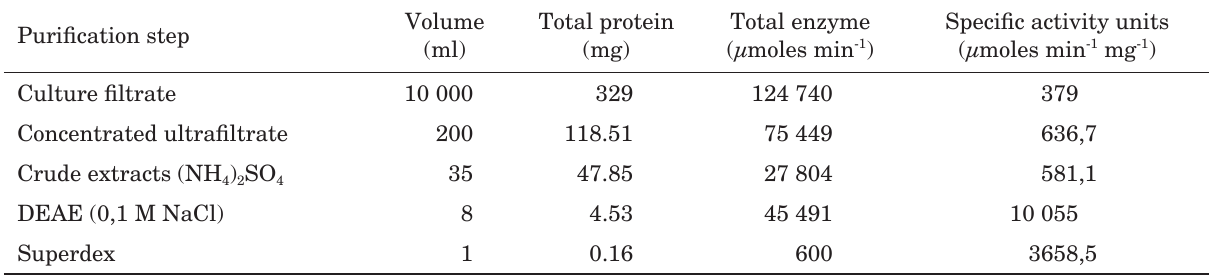
Table 1. Purification steps for the laccase produced by Fomitiporia mediterranea .